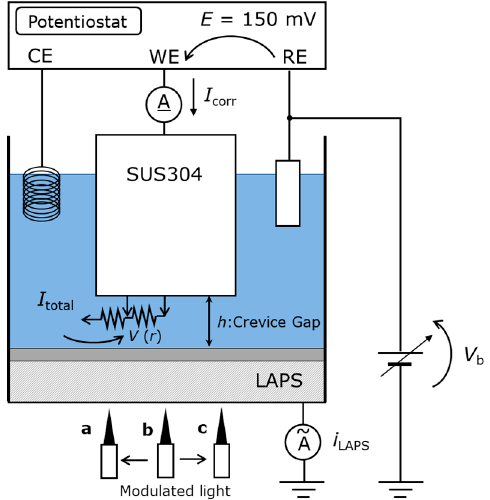
Figure 1. Setup for simultaneously performing the potentiostatic test and light-addressable potentiometric sensor (LAPS) measurement. RE, WE, and CE indicate the reference electrode, working electrode, and counter electrode, respectively. In this experiment, an Ag/AgCl (3M NaCl) electrode, a SUS304 specimen, and a platinum wire were used as the RE, WE, and CE, respectively. The potentiostat was used to apply a controlled potential to the specimen and to monitor the corrosion current I corr . The points of illumination a , b , and c correspond to the surface locations shown in the top-right image of Figure 2.